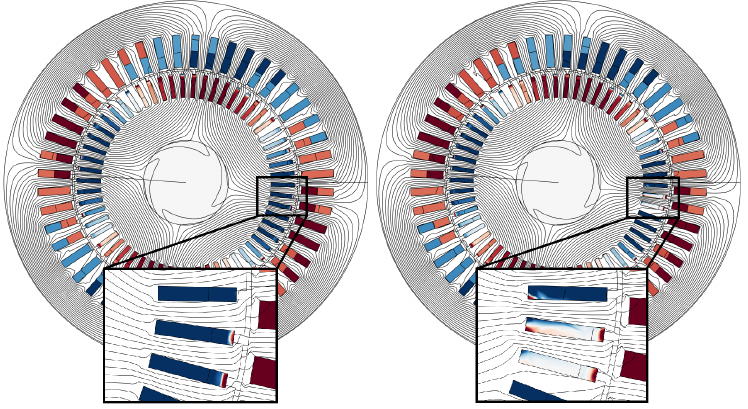
Figure 2. A visualization of magnetic flux lines and electrical current densities in the 2D FE simulation in a cross-section of the IM. On the left : a healthy case; on the right : two BRBs.